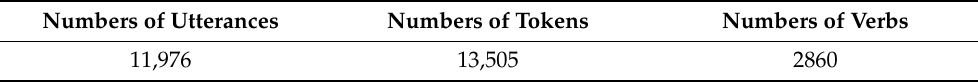
Table 11. Number of analyzed